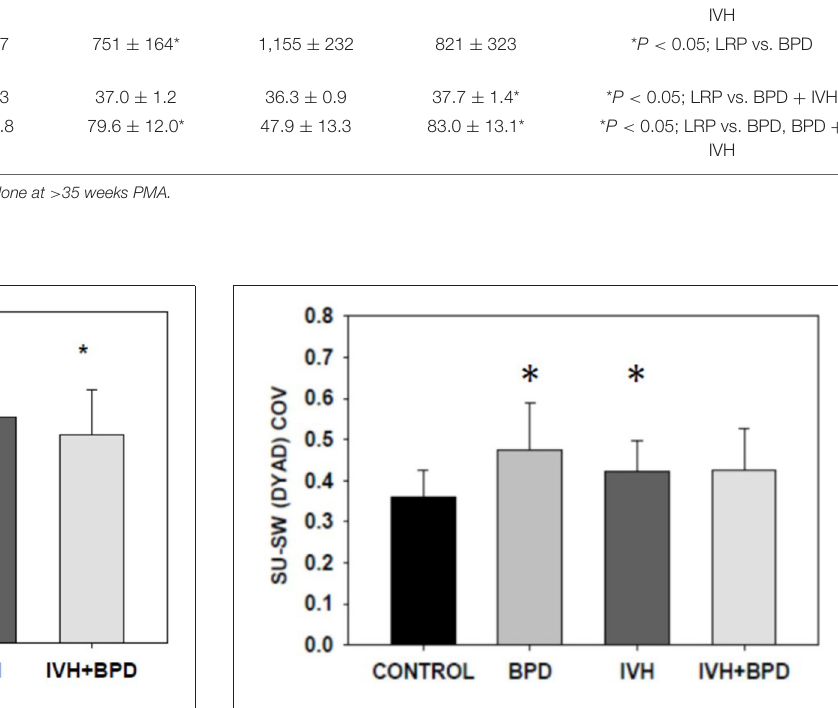
FIGURE 2 | Suck-swallow (SU-SW) dyadic COV at > 35 weeks PMA. In premature infants 35–42 weeks PMA, the stability of suck-swallow rhythm is greater (lower coefficient of variation) in control LRP infants compared to infants with BPD, IVH, and IVH + BPD ( p < 0.05; ANOVA; Dunnett’s post-hoc test). * p < 0.05 vs. LRP. Data is given as mean ± S.D.